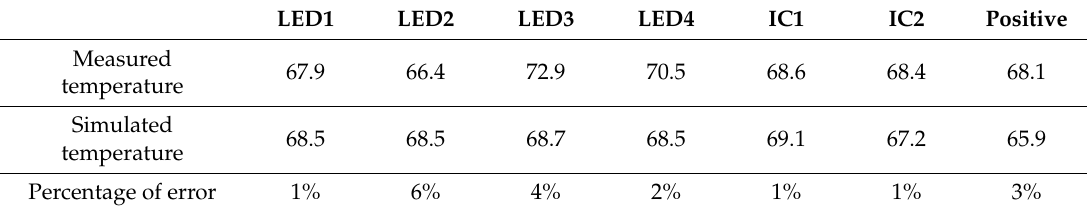
Table 1. Comparison of simulated and experimental temperature results of MSA0095-graphene TIM.